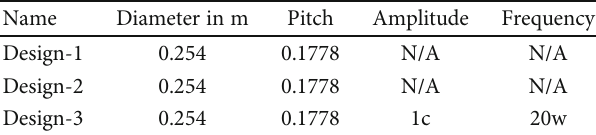
Table 1: The geometry design of